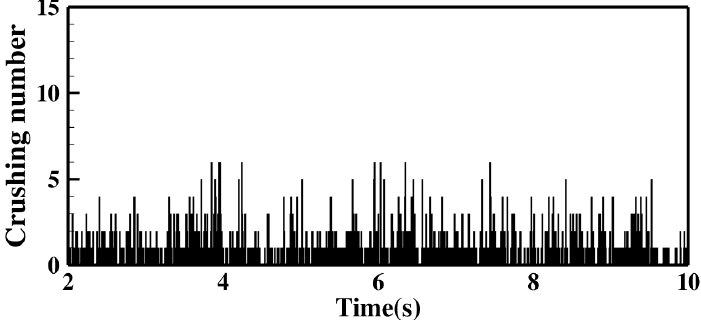
Figure 8. The change of the total particle number during the simulation of PCPM.